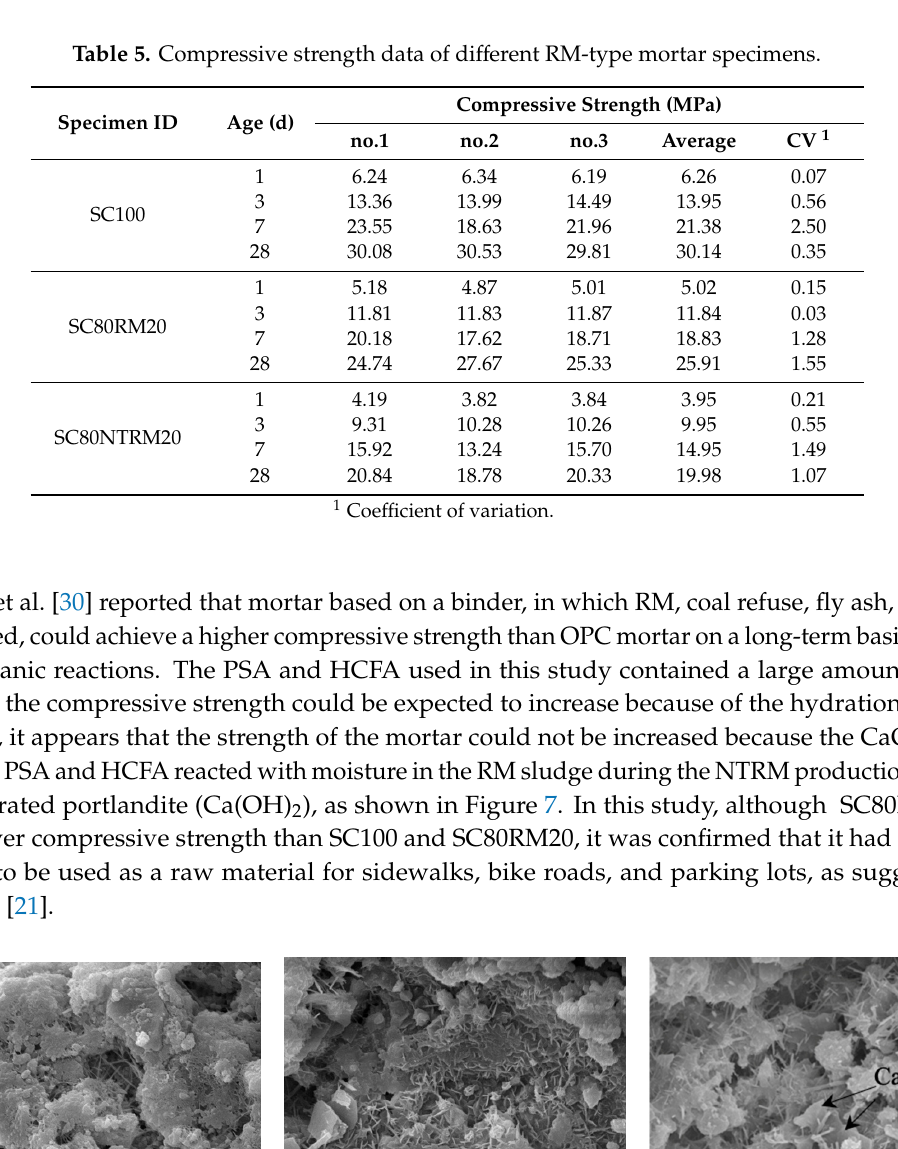
Table 5. Compressive strength data of di ff erent RM-type mortar specimens.